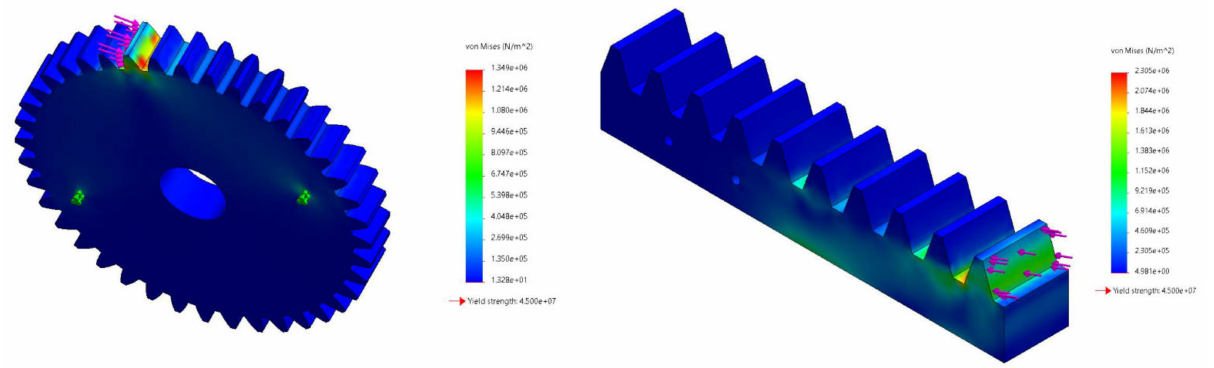
Figure 10. Maximum stresses developed within rack and pinion gear